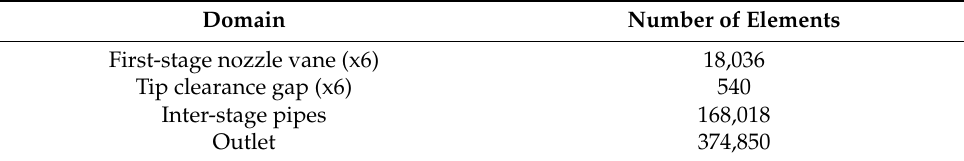
Table 2. The number of cells for each